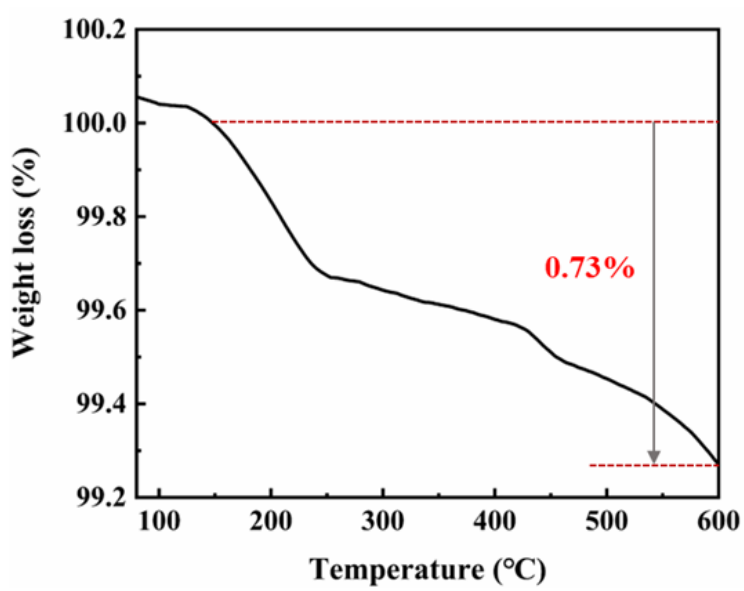
Figure 4. TGA thermogram of silver powder.